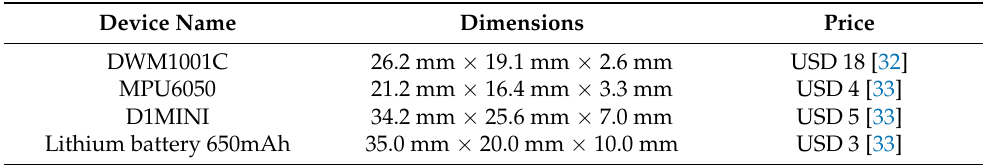
Figure 4. Wearable IoT device. ( a ) Placement of UWB and IMU module at right shoe; ( b ) circuit diagram of custom board. Table 1. Specifications of low-cost foot-placed